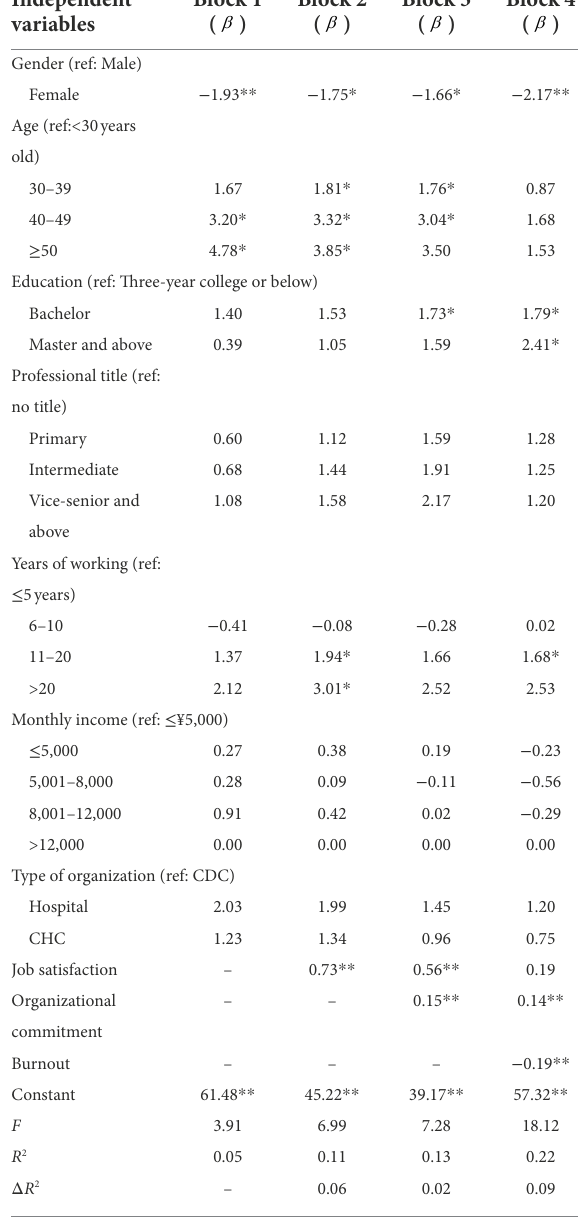
TABLE 2 Job satisfaction, organizational commitment, burnout and job performance among HCPs.